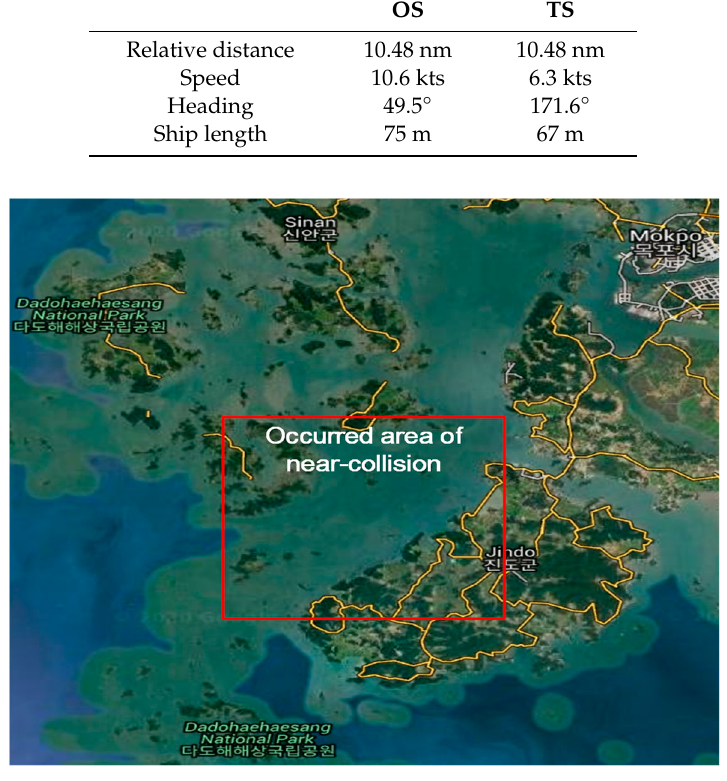
Figure 13. Occurred area of near-collision between the OS and the TS.